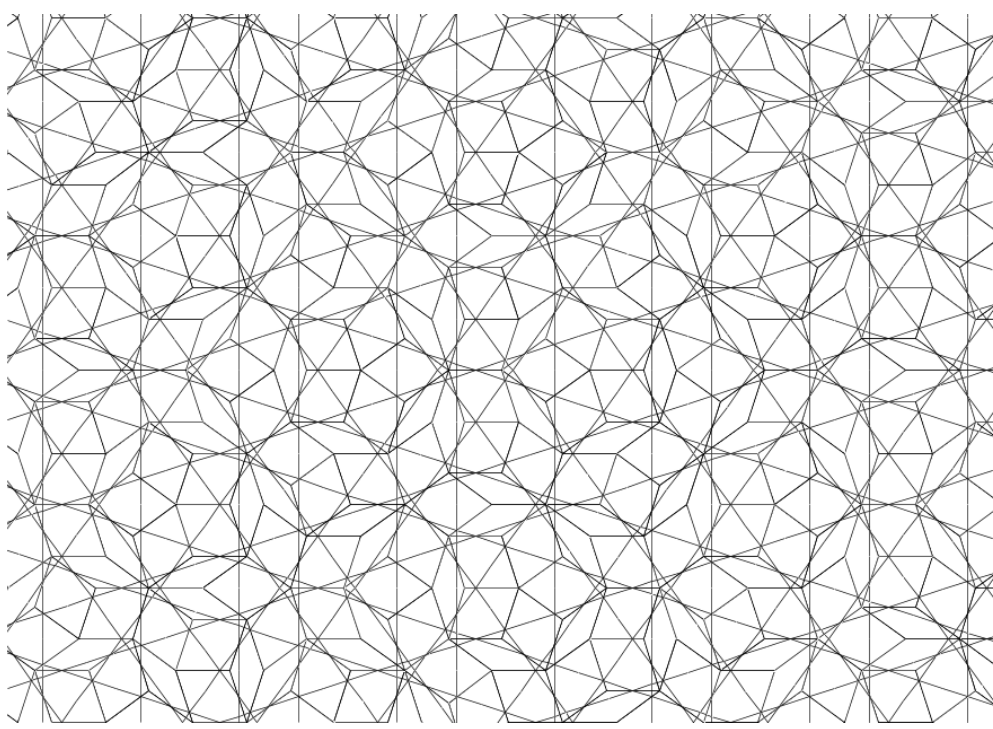
Figure 2. Ammann bars in Penrose